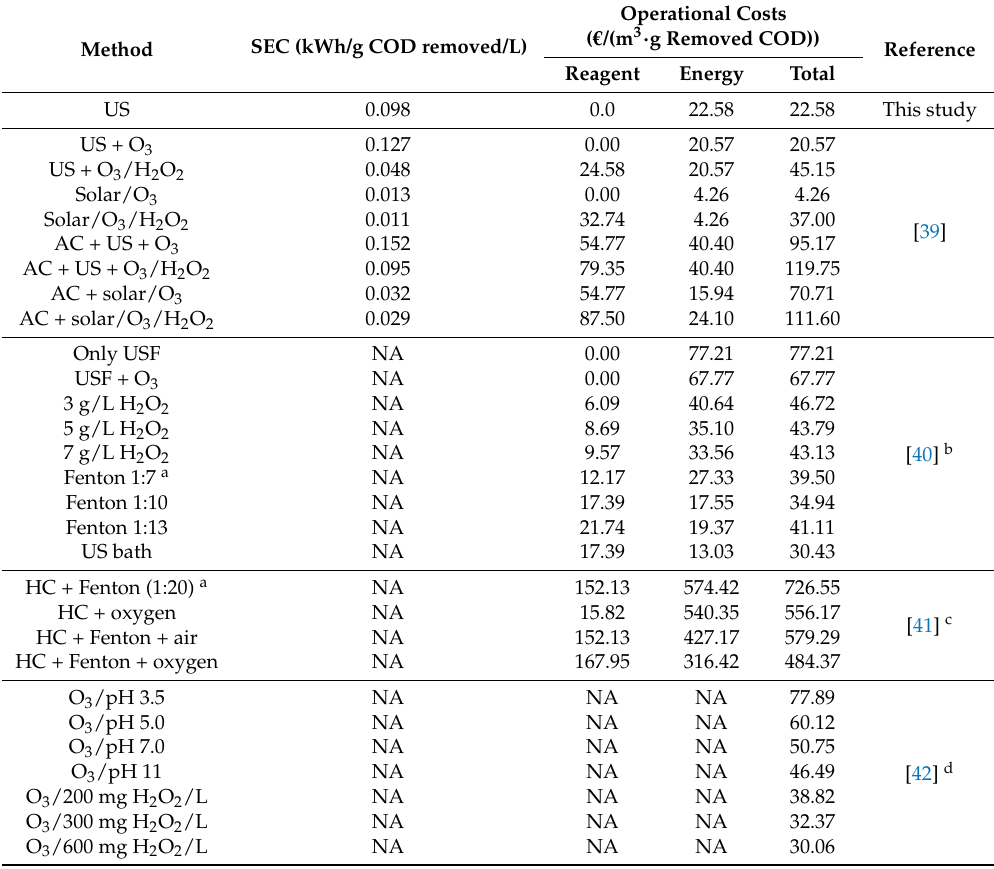
Table 7. Comparison of specific energy consumption and operational cost in this study with other